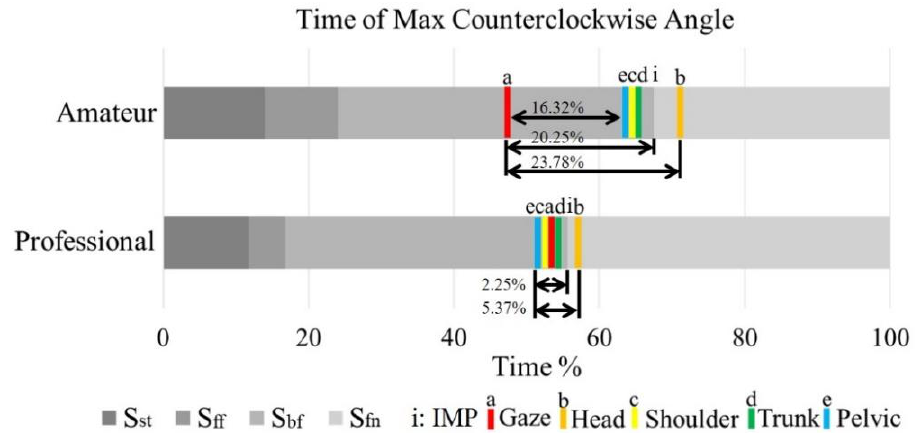
Figure 5. The maximum angular velocity timing of each segment in the swing cycle. The amateur group cost about 23.78% cycle time to complete the maximum angular velocity. However, the profes- sional group cost only about 5.37% cycle time. The maximum gaze angular velocity timing of the amateur group was significantly earlier (16.32% cycle time) than the other segments’ intragroup.